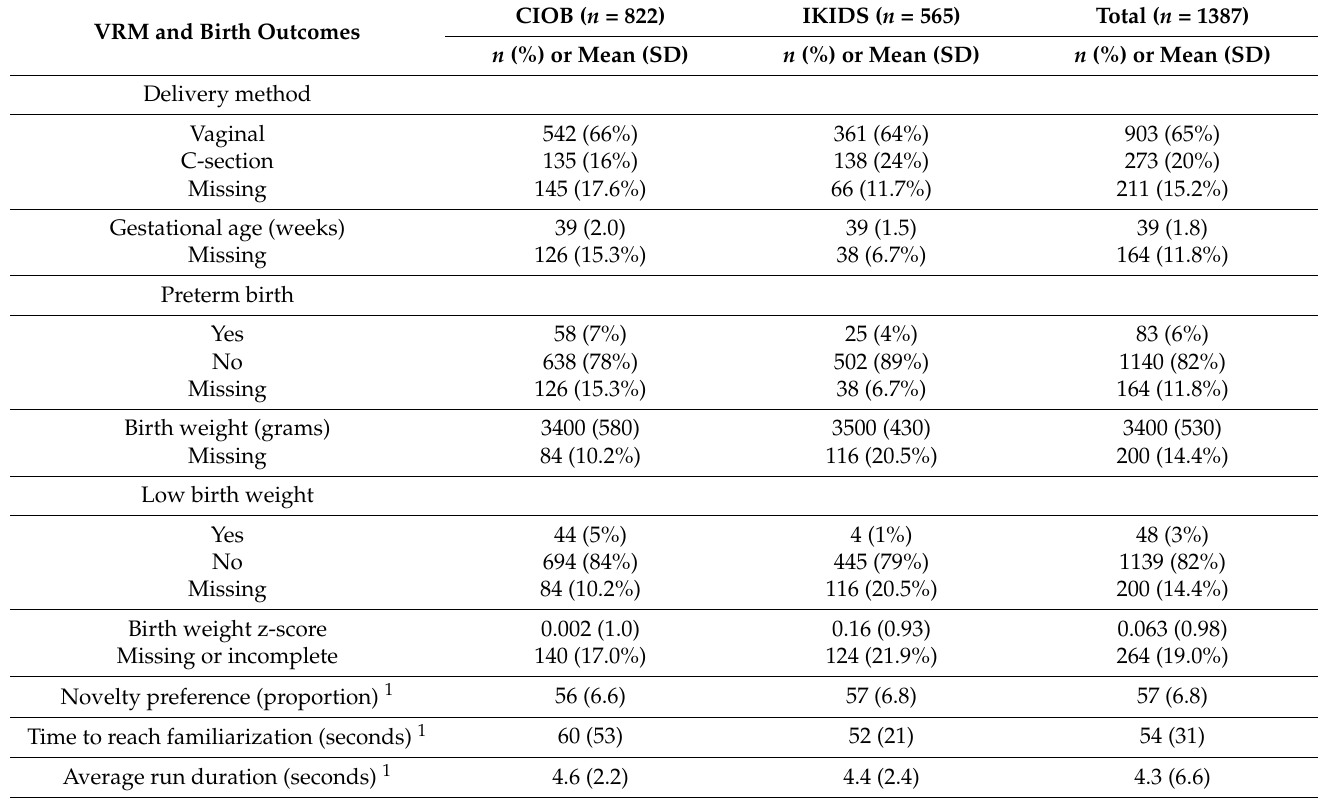
Table 2. Distribution of birth outcomes and visual recognition memory (VRM) outcomes from face trials in ECHO.CA.IL